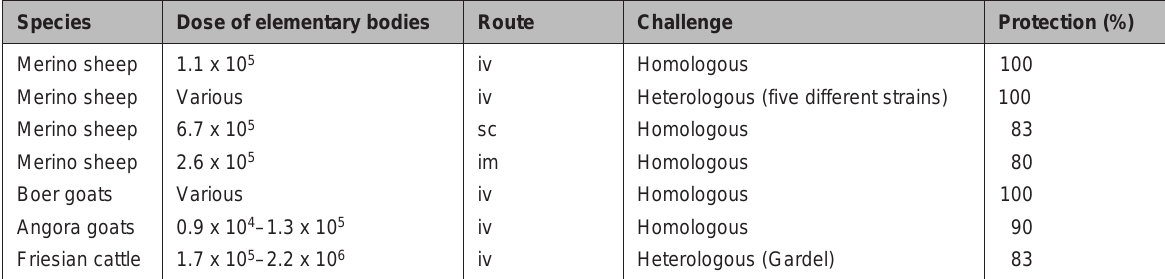
TABLE 1 Immunising ability of attenuated E. ruminantium Welgevonden (after Zweygarth et al . 2008) Species Merino sheep Merino sheep Merino sheep Merino sheep Boer goats Angora